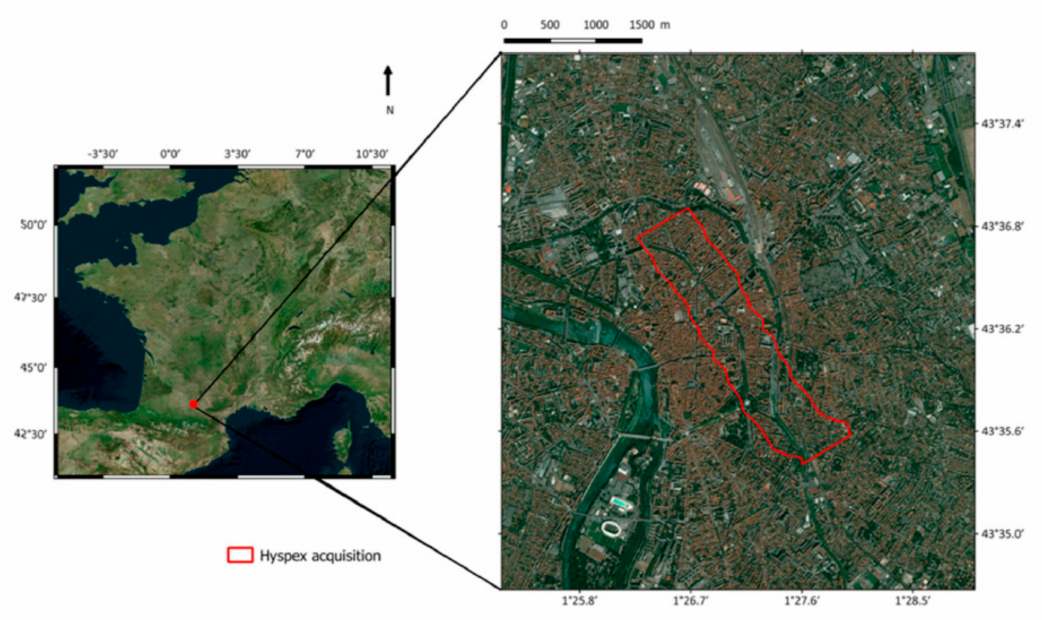
Figure 3. The considered Toulouse (France) urban area [33].